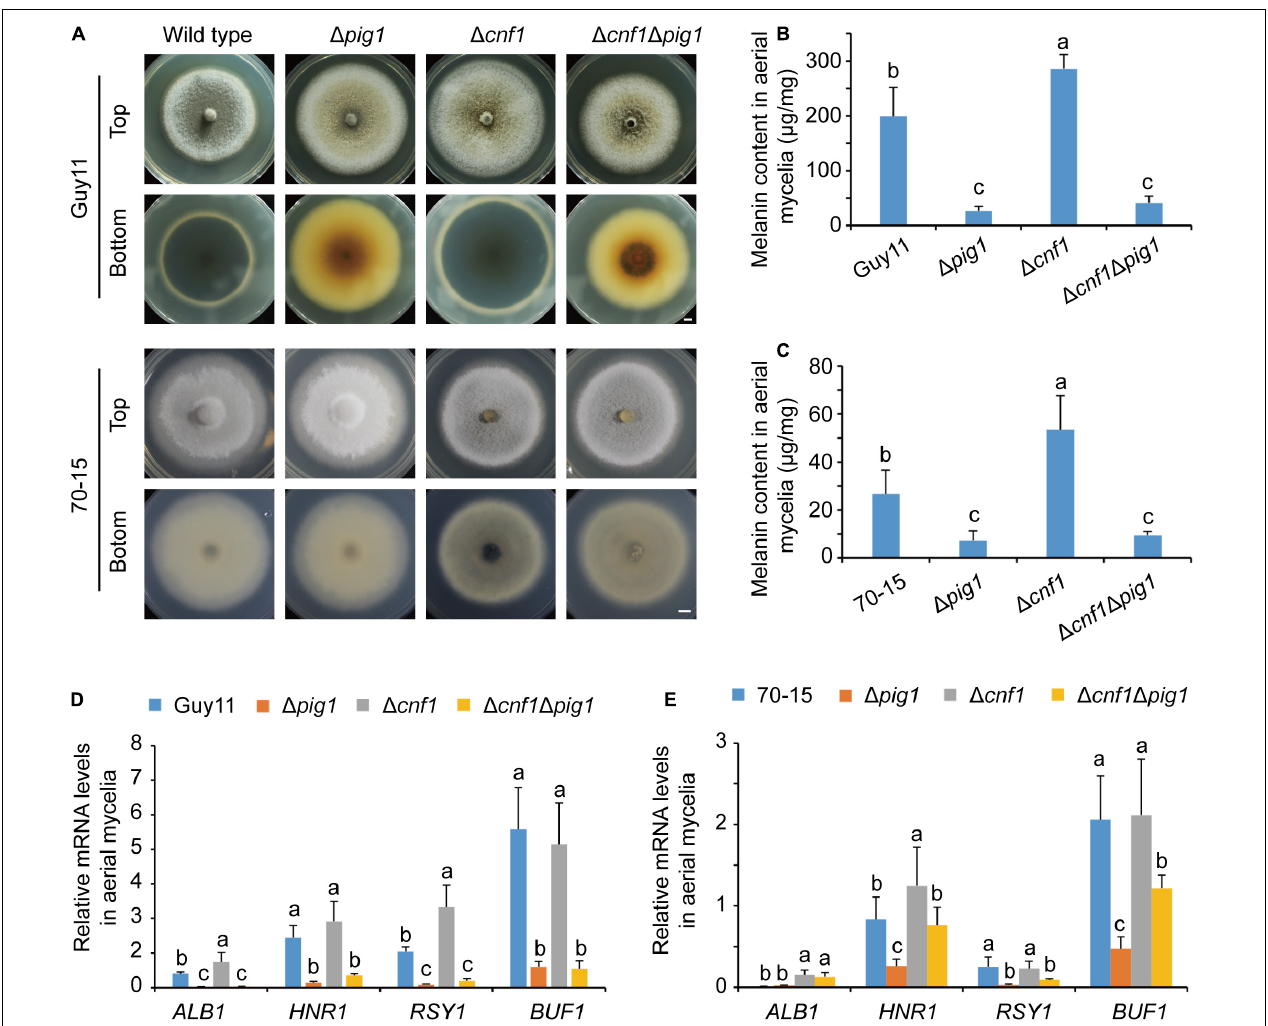
FIGURE 1 | The different functions of Pig1 and Cnf1 on hyphal melanin synthesis in the rice blast fungus. (A) Colonial morphology and color. Bar = 5 mm. (B) Melanin contents in aerial mycelia of Guy11 and its mutants. (C) Melanin contents in aerial mycelia of 70-15 and its mutants. (D,E) Relative expression levels of four melanin synthesis genes ( ALB1 , HNR1 , RSY1 , and BUF1 ) in aerial mycelia of Guy11 (D) and 70-15 (E) with α - ACTIN and 40S as reference genes. (B–E) Error bars represent ± SD. Different lowercase letters represent significant differences between four strains as estimated by Tukey’s HSD test ( p < 0.05).